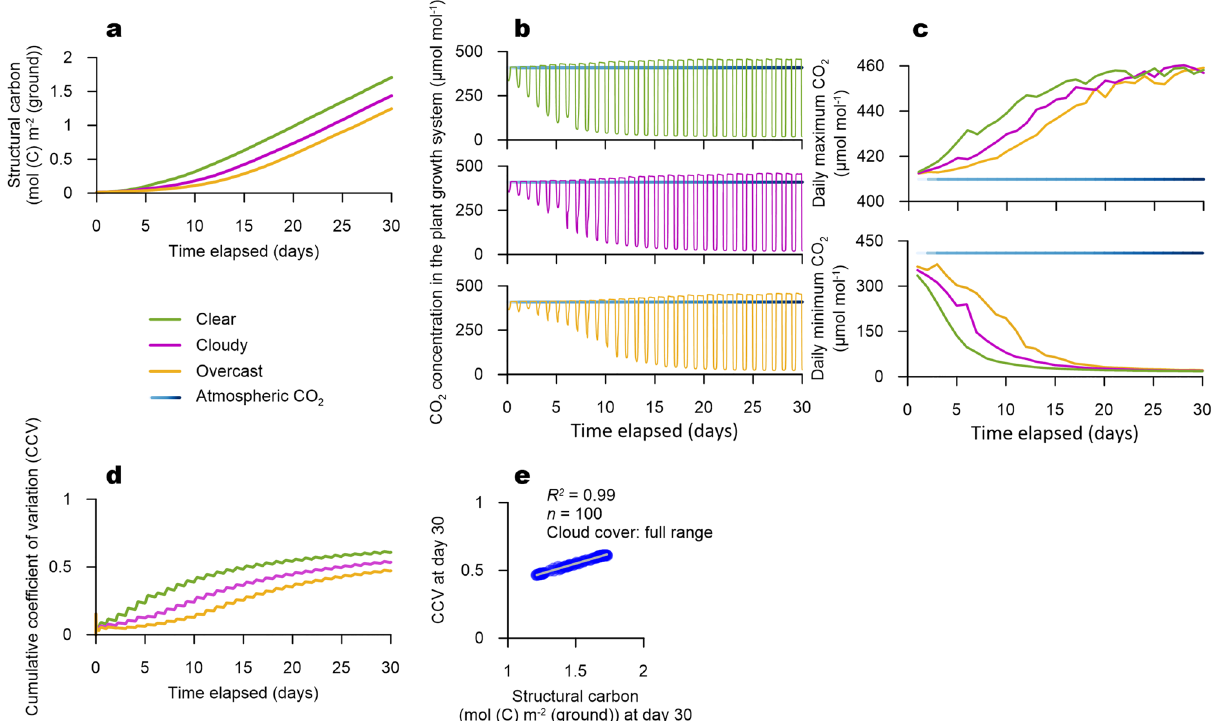
Figure 3. Simulation results of the coupled model Results for structural carbon accumulation in the coupled model simulation ( a ) and corresponding CO 2 oscillations in the plant growth system air ( b ). Data filtration of the CO 2 oscillations by daily maximum and minimum functions exhibiting gradual deviation of the CO 2 variations from the atmospheric CO 2 concentration ( c ), CCV progress curves from the three climatic regimes generated sigmoidal curves accounting for each climatic regime ( d ), and the correlation analysis showed a high positive correlation between CCV and structural carbon at day 30 of the full range climatic regime ( e